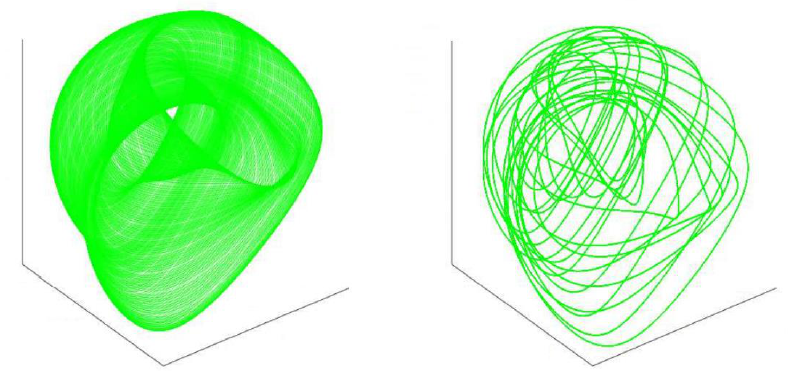
Figure 3. Idealized phase spaces representing all possible states in a neurodegenerative system, each phase state represented by one point of space-time, protein interaction, time, and movement (figure reproduced with permission from ref [13]. Copyright 2011 Elsevier).